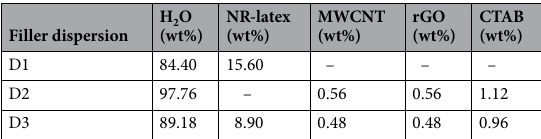
Table 1. Formulation of filler-based aqueous dispersions.